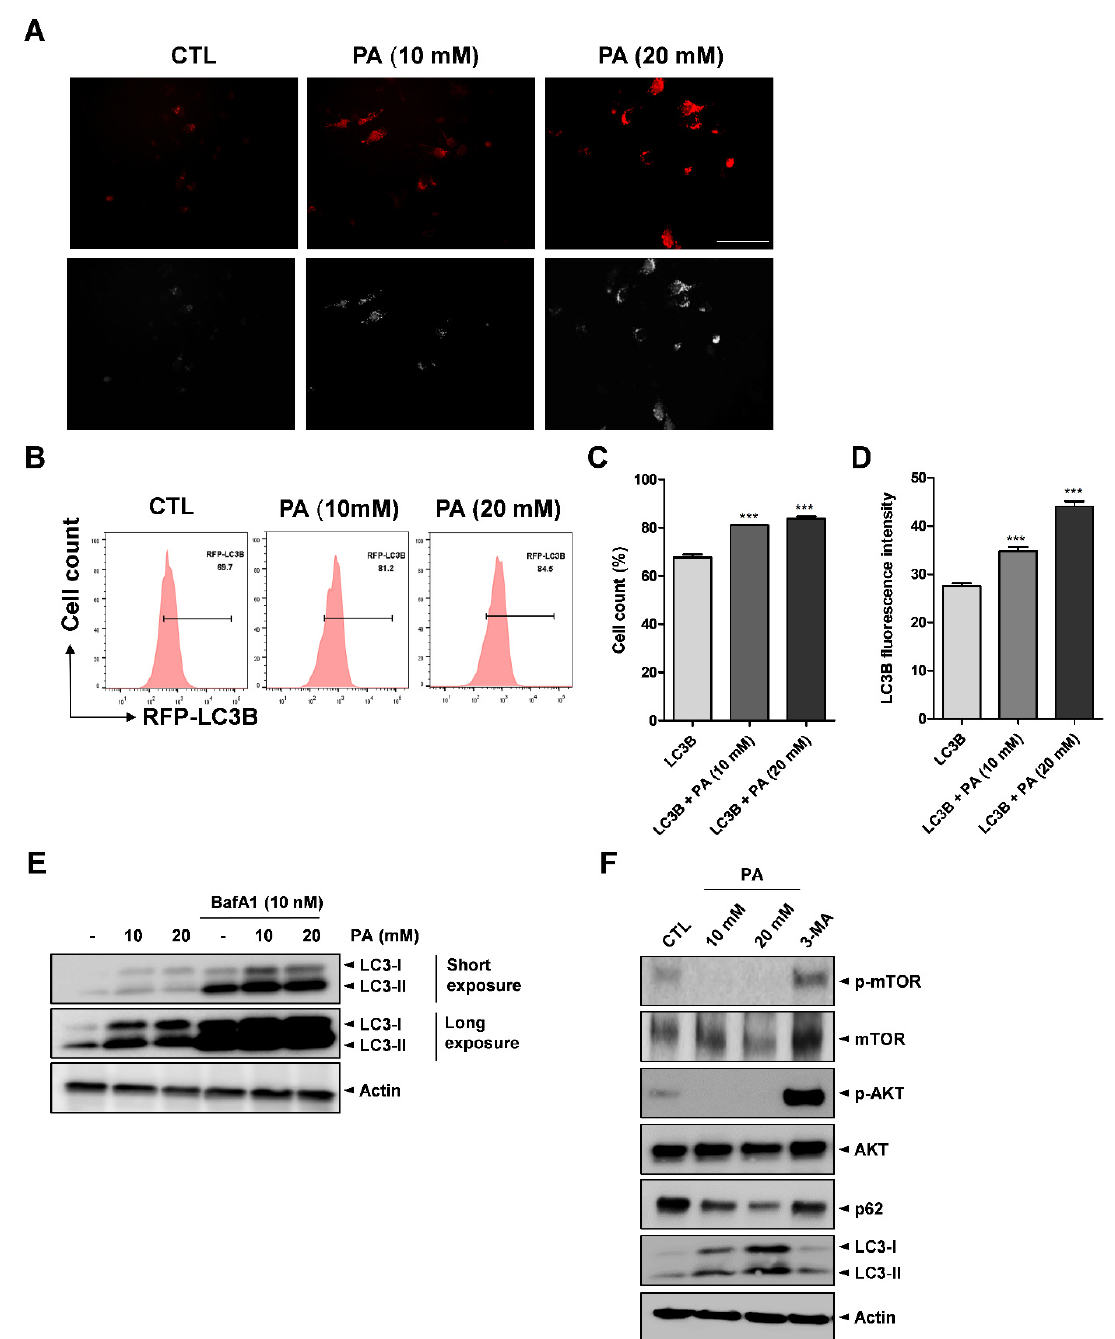
Figure 6. PA-activated autophagy. RFP-LC3B was transfected into HeLa cell for 16 h then treated with PA for 24 h. ( A ) Fluorescence microscopy results used to analyze the effects of PA with LC3B puncta (white arrows) formation (scale bar: 200 µ m). ( B ) Effects of 10 mM and 20 mM PA on LC3B puncta formation using RFP-LC3B and RFP as measured using a flow cytometer. ( C ) Quantification of RFP-LC3B. ( D ) Quantitative analysis of LC3B median fluorescence intensity. ( E ) Representative images of immunoblot analysis results of LC3B obtained from autophagy flux assays. The cells were pretreated with 10 nM Bafilomycin A1 (BafA1) for 4 h then treated with PA for 24 h. ( F ) Expressions of p-mTOR (Ser2448), mTOR, p-AKT (Ser473), AKT, p62, LC3B, and actin as assessed by Western blot analysis. 5 mM of 3-Methyladenine (3-MA) were pretreated for 4 h then treated with PA for 24 h. *** p <